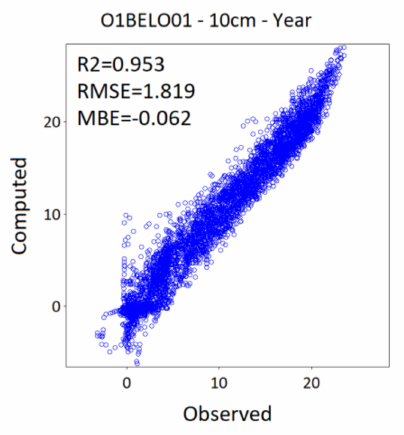
Figure A9. Validation at site O1BELO01 for 10 cm soil depth.